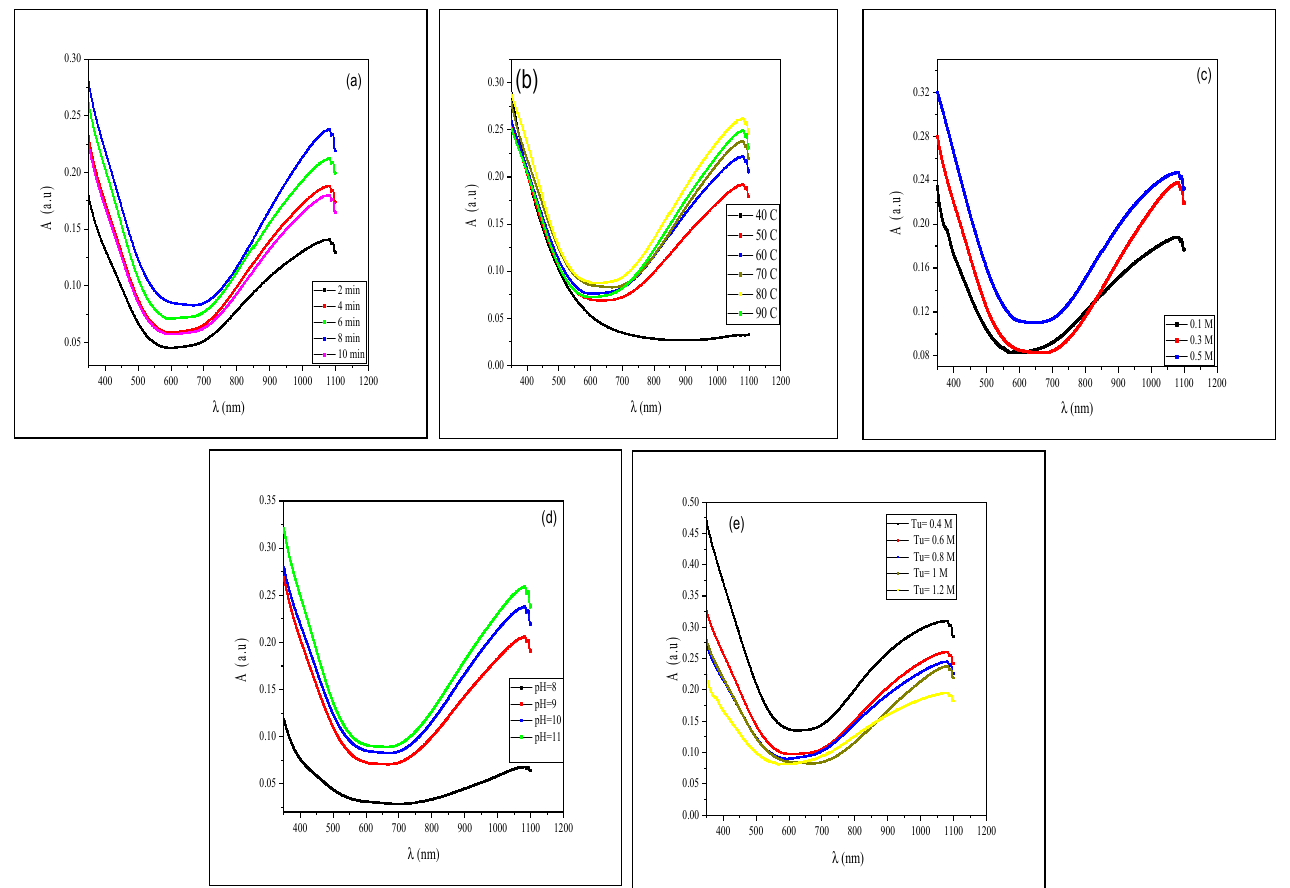
Figure 5. Absorbance of Cu 2 S thin films as a function of different deposition parameters: ( a ) Depo- sition time, ( b ) bath temperature, ( c ) CuSO 4 .5H 2 O concentration, ( d ) pH value, and ( e ) SC (NH 2 ) 2 concentration.